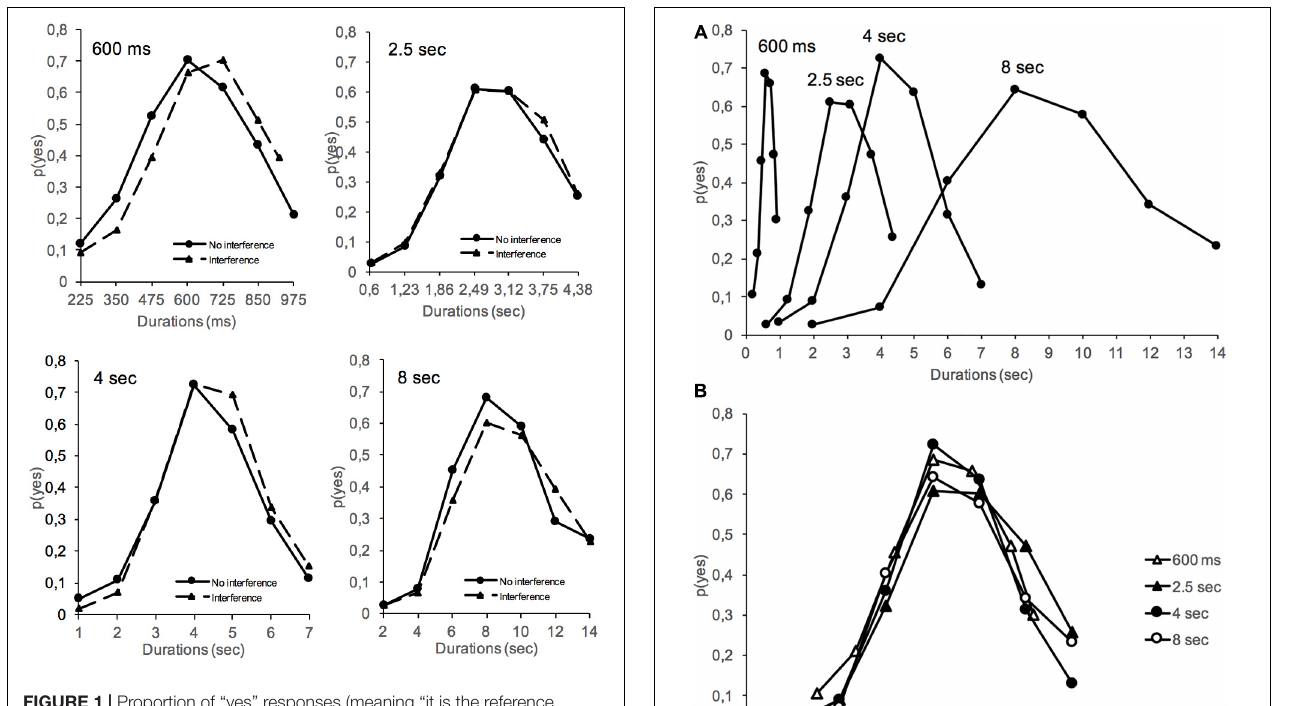
without interference [0.278 vs. 0.187, F (1,198) = 3.355, p =